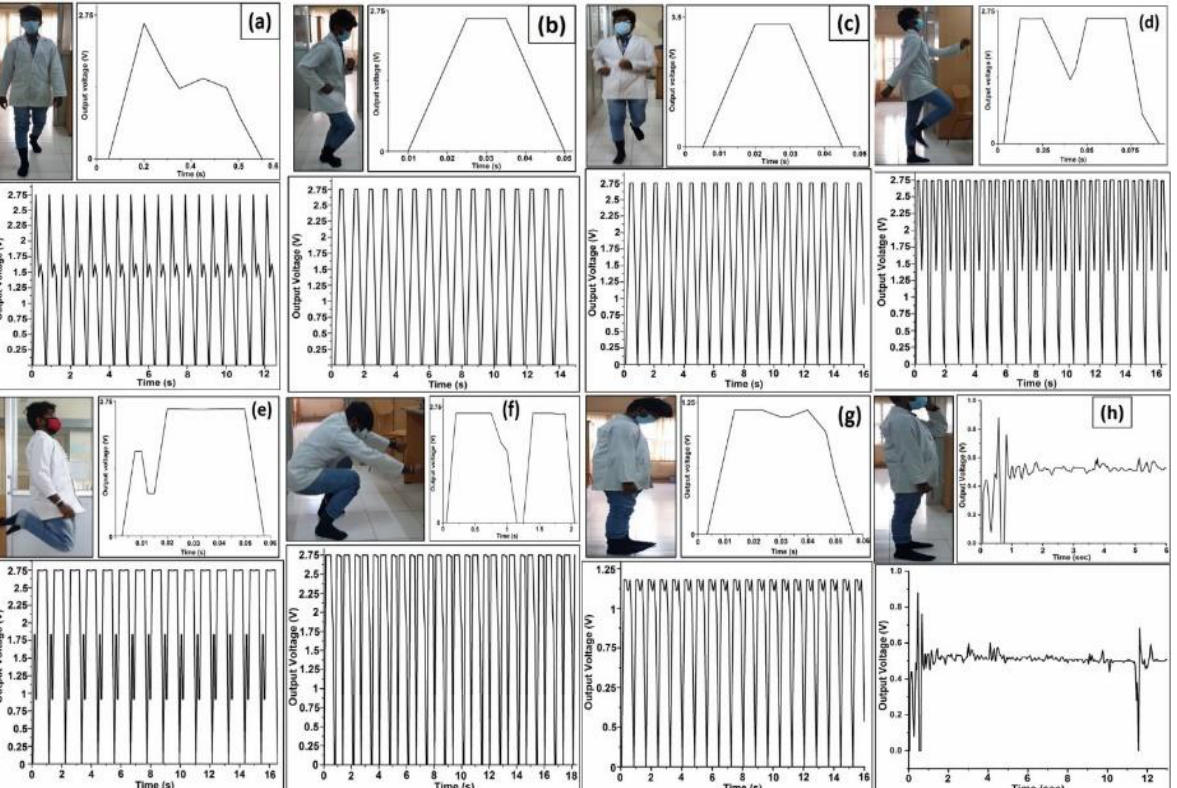
Figure 8. The piezoelectric voltage response of the SF-based sensor with CNF densities equal to 0.4%, analyzed for various human motions which include: ( a ) walking; ( b ) jogging; ( c ) running; ( d ) marching; ( e ) jumping; ( f ) squatting; ( g ) tapping and ( h ) standing [Video S1: movement analyses].